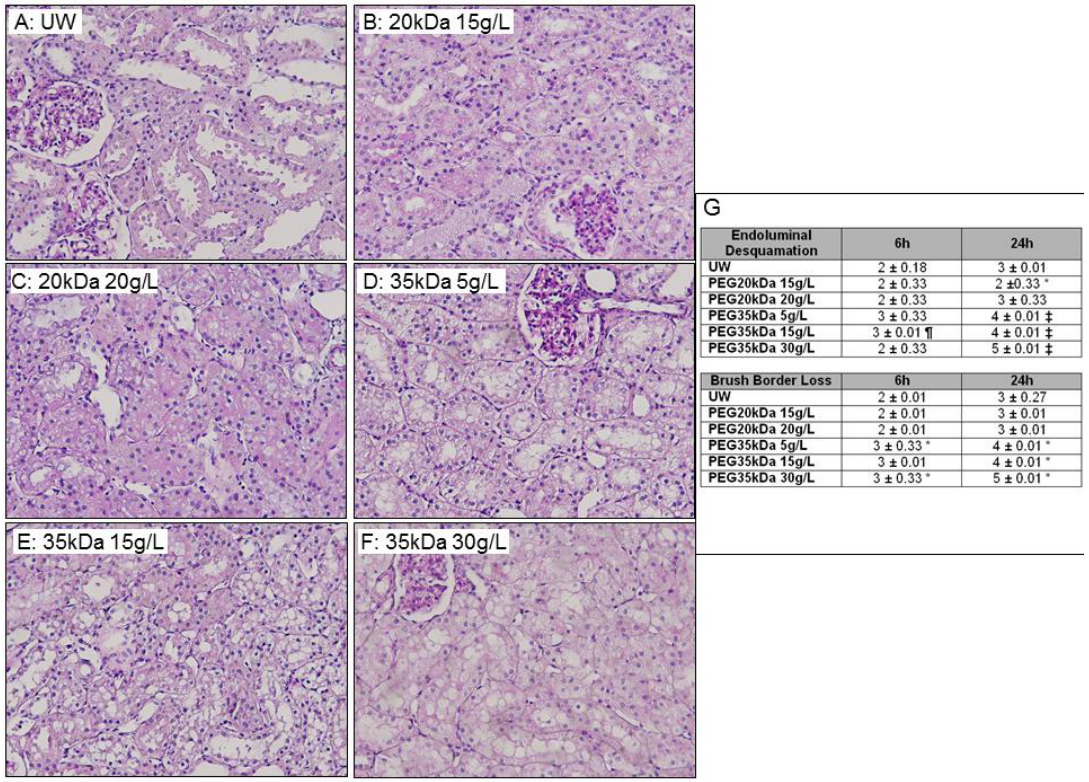
Figure 3. Histological Evaluation of Preserved Kidneys. ( A – F ) Representative Histology of preserved kidneys after 24 h preservation. Kidneys were preserved in the indicated solution for 24 h before processing for histological evaluation. Magnification: 200 × ; ( G ) Evaluation and scoring of histological lesions development during kidney preservation. Histological scoring was done according to the following grades: 0—no abnormality; 1—less than 10%; 2—10–25%; 3—26–50%; 4—51–75%; 5—more than 75%. Statistics: * p < 0.05 vs. UW, ‡ p < 0.05 vs. PEG 20 kDa, ¶ p < 0.05 vs. UW et PEG 20 kDa. n = 3.